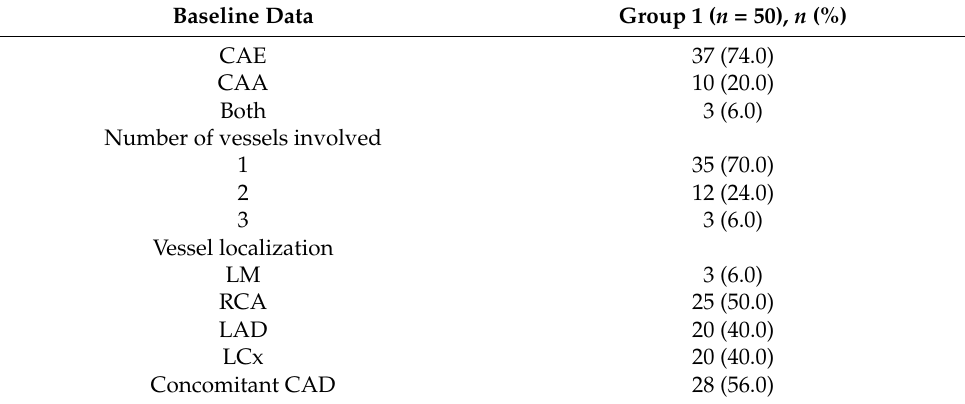
Table 2. Angiographic characteristics of Group 1 (CAAD group).